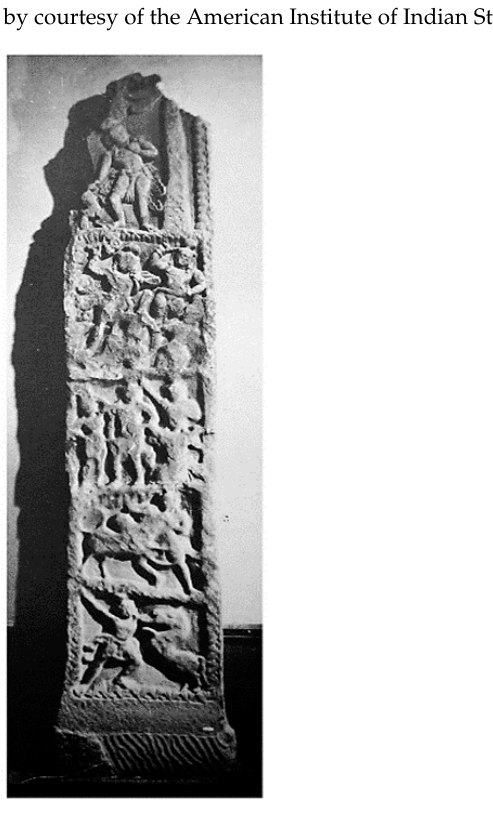
Figure 3. Doorjamb with Exploits of the Young K ṛṣṇ a, fourth–sixth century. Ma ṇḍ or, Rajasthan. Sandstone. Jodhpur Museum (photo by courtesy of the American Institute of Indian Studies).